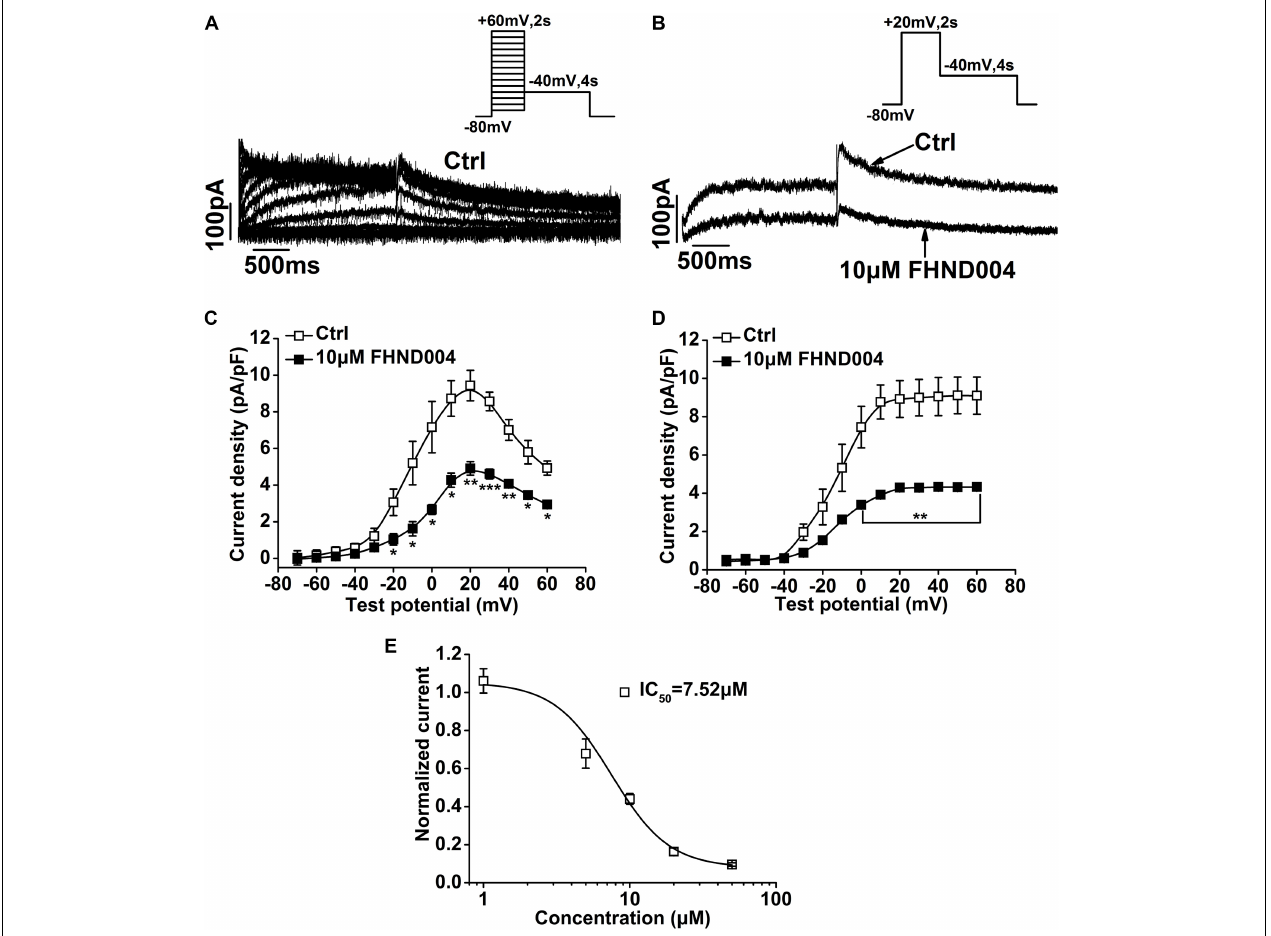
FIGURE 2 | Effects of FHND004 on I Kr recorded from HL-1 cells. (A) Families of hERG current elicited by the voltage protocol shown in the inset. (B) Peak current elicited by the voltage protocol shown in the inset in the absence and presence of 10 µ M FHND004. (C,D) I – V relationships for step and tail currents in the absence and presence of 10 µ M FHND004, respectively ( n = 6). (E) Concentration–response relationships fitted with Logistic equation for block of I kr tail current by FHND004 ( n ≥ 4 per data point); k is 2.21 ±